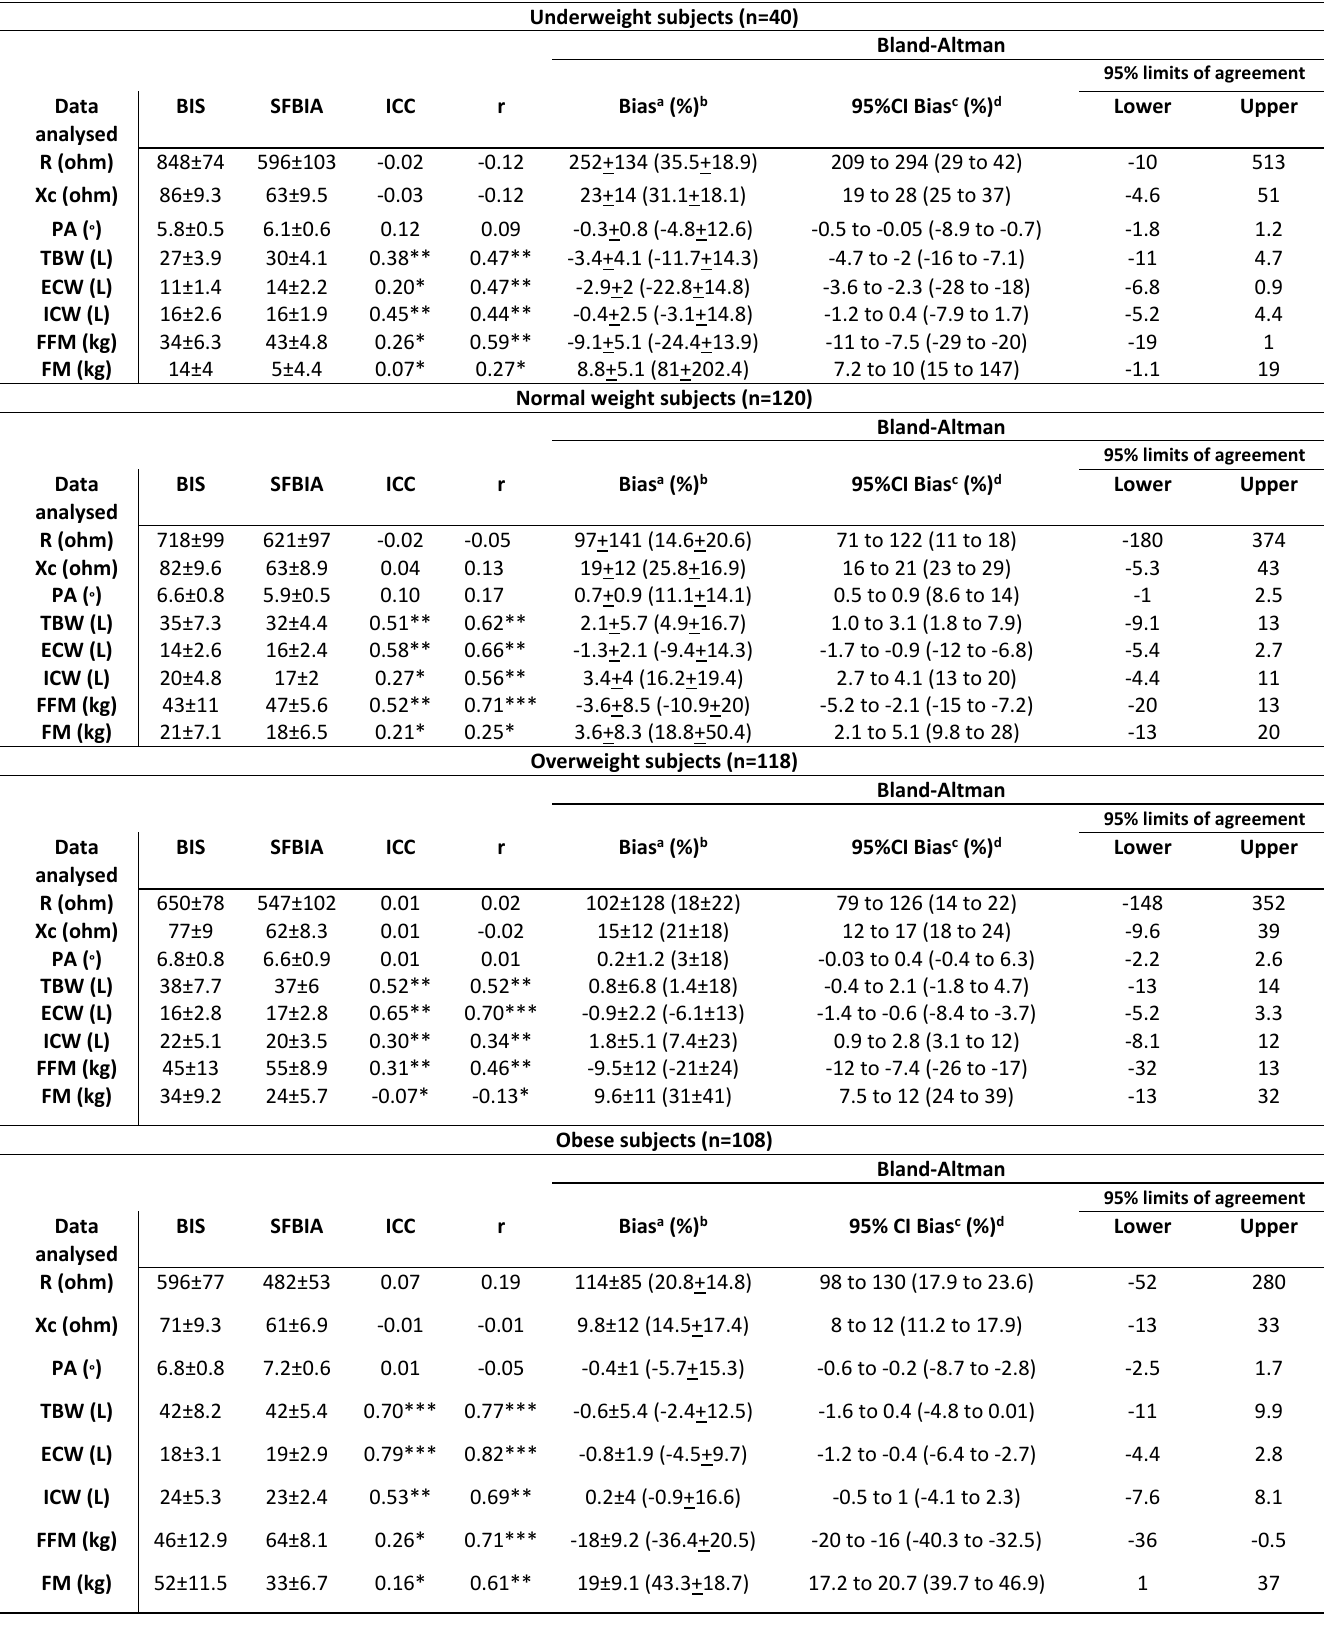
Table 2. Statistics of BIS vs SFBIA data in non-CKD BMI stratified subgroup